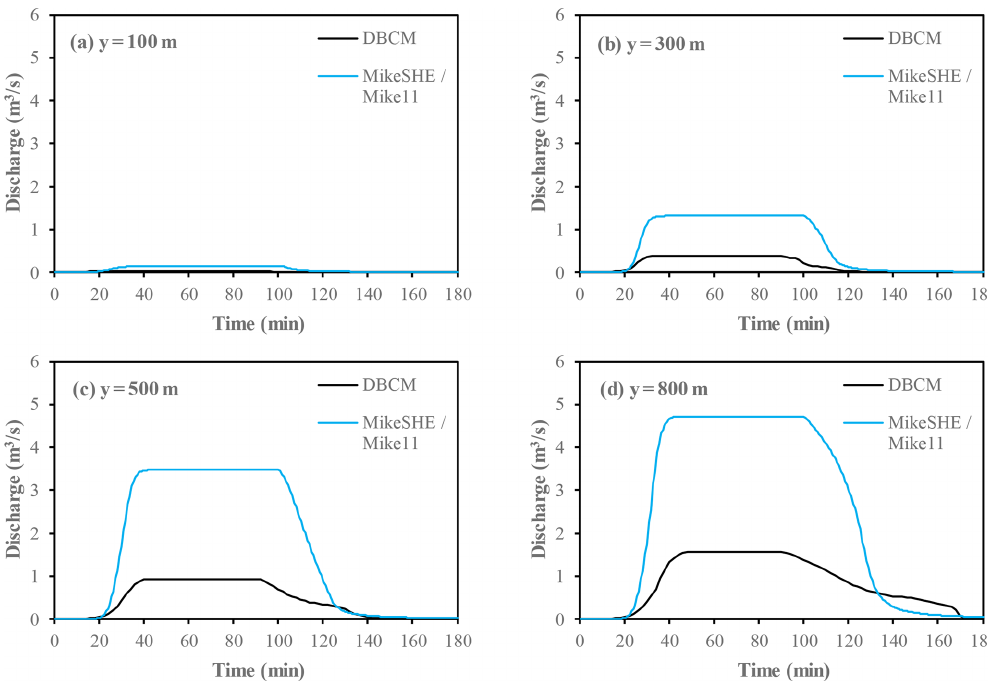
Figure 13. Discharge processes in the centre channel.